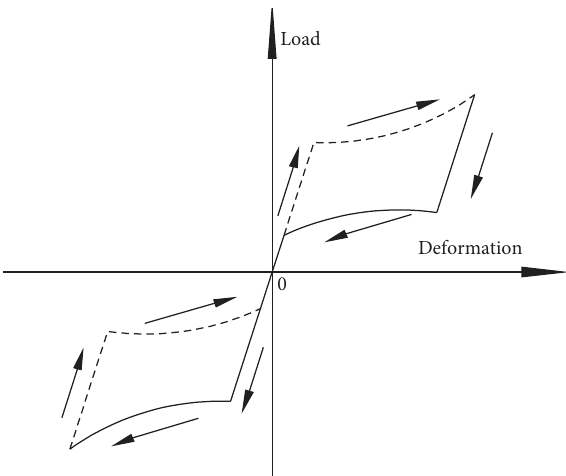
Figure 10: The expectant constitutive model of SCVF brace.